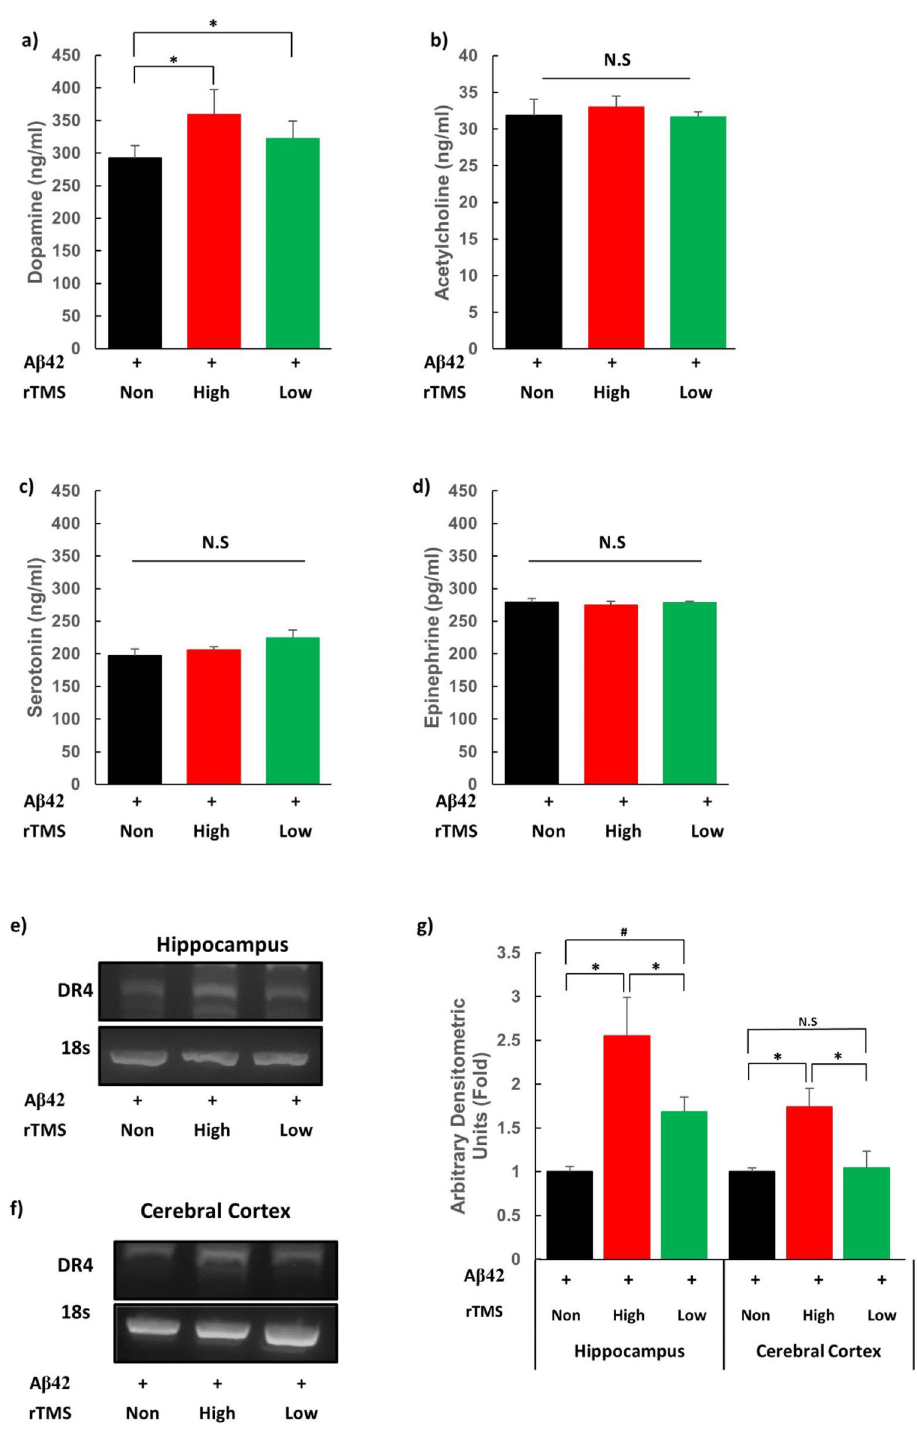
Figure 3. rTMS elevates concentration of dopamine and gene expression of DR4 in AD mouse model. The concentrations of neurotransmitters were measured after rTMS from tissue homogenates lysate of the hippocampus ( a ) Dopamine, ( b ) Acetylcholine, ( c ) Serotonin, and ( d ) Epinephrine. rTMS regulated dopaminergic signalling pathway through DR4. The expression of DR4 was measured by RT-PCR in ( e ) Hippocampus and ( f ) Cortex ( g ) Histograms show densitometry analysis of DR4 RT-PCR. Each group n = 3, mean ± SEM.* Ps < 0.05, # = 0.069. + Aβ42 oligomer injected via ICV, rTMS repetitive transcranial magnetic stimulation, DR4 Dopamine receptor 4, AD Alzheimer’s Disease, RT-PCR reverse transcription polymerase chain reaction, Aβ42 amyloid beta 42 oligomer, None none treatment, High high frequency rTMS treated, Low low frequency rTMS treated, N.S. not